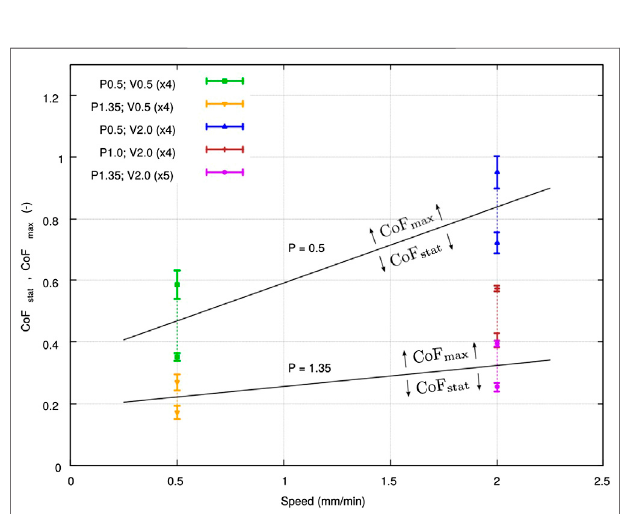
FIGURE13| Results ofinter-ply slidingtest: maximum andstatic friction coef fi cients vs. adjacent plies relative speed.